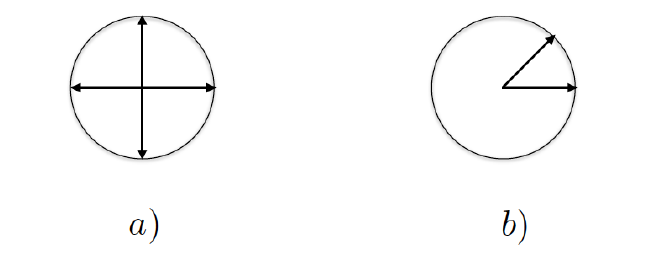
Figure 1 . Allowed kinematic con(cid:12)guration for quasi-particle scattering. Diagram (a) is the BCS back to back con(cid:12)guration which leads to Cooper pair condensation. (b) Forward scattering, in which the (cid:12)nal state momenta lie on top of the initial state